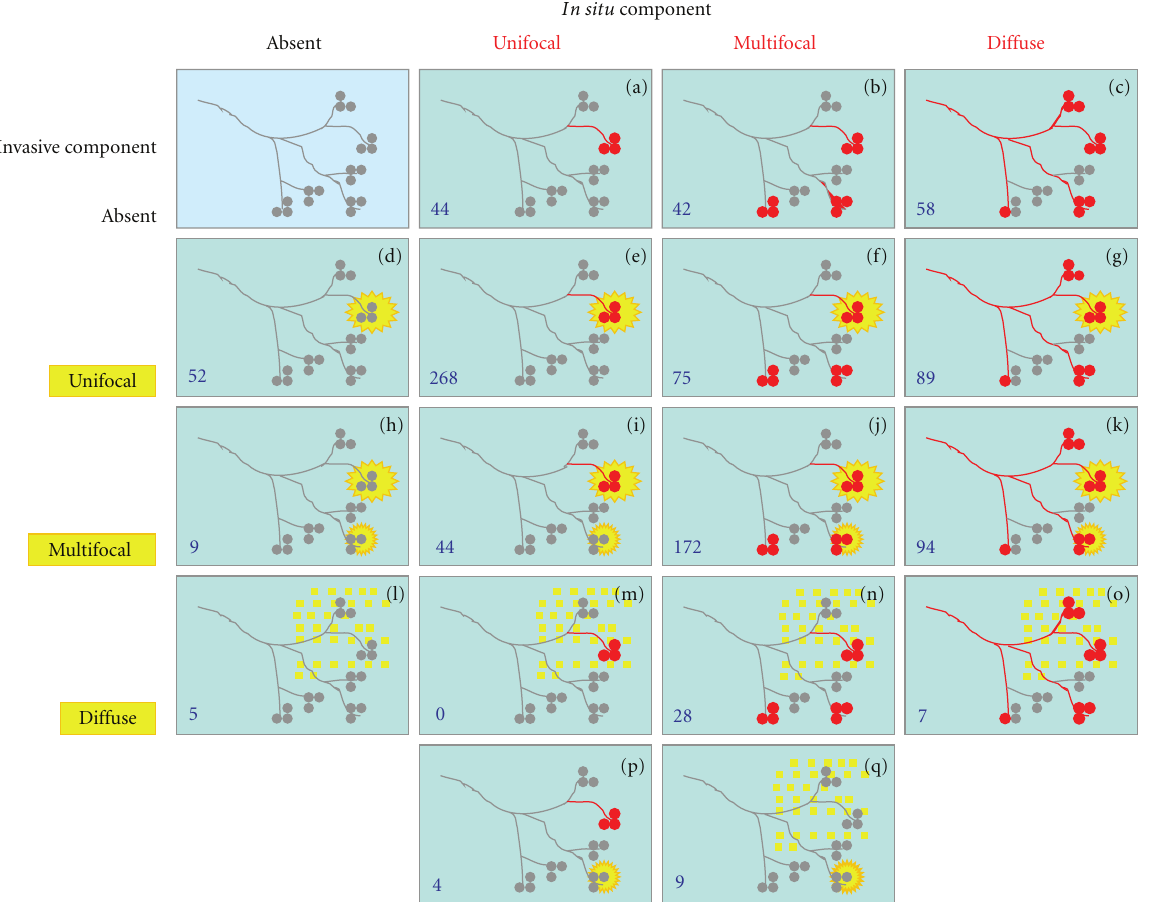
Figure 2: Schematic illustration of the possible combined growth patterns in breast carcinomas. (a) Unifocal in situ component, no invasive component. (b) Multifocal in situ component, no invasive component. (c) Di ff use in situ component, no invasive component. (d) Unifocal invasive component, no in situ component. (e) Unifocal invasive component, unifocal in situ component within the area of the invasive focus, and unifocal combined pattern. (f) Unifocal invasive component, multifocal in situ component, and multifocal combined pattern. (g) Unifocal invasive component, di ff use in situ component, and di ff use combined pattern. (h) Multifocal invasive component, no in situ component. (i) Multifocal invasive component, unifocal in situ component in one of the invasive foci, and multifocal combined pattern. (j) Multifocal invasive component, multifocal in situ component, and multifocal combined pattern. (k) Multifocal invasive component, di ff use in situ component, and di ff use combined pattern. (l) Di ff use invasive component, no in situ component. (m) Di ff use invasive component, unifocal in situ component, and di ff use combined pattern. (n) Di ff use invasive component, multifocal in situ component, and di ff use combined pattern. (o) Di ff use invasive component, di ff use in situ component, and di ff use combined pattern. (p) Unifocal invasive component, unifocal in situ component outside the invasive focus, and multifocal combined pattern. (q) Drawing illustrating one of the possible mixed patterns with both di ff usely growing and well-delineated invasive foci, with a di ff use combined pattern. The upper right image illustrates the sick lobe. Numbers in the lower left corner of the drawings indicate the number of cases in the series of 1000 consecutive breast carcinomas belonging to that